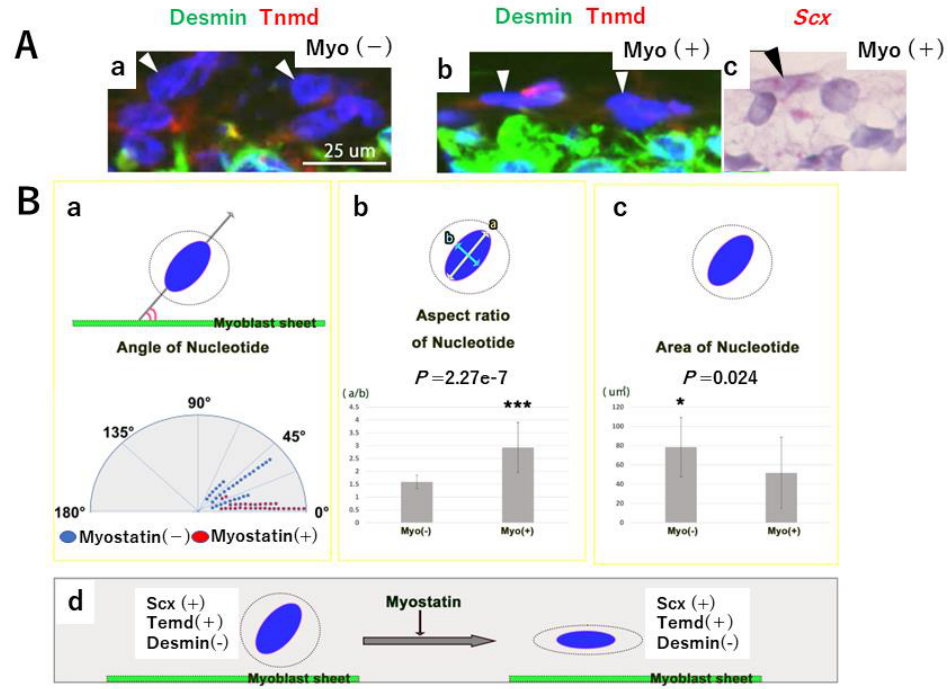
Figure 6. Boundary between C2C12 and gel in C2C12-Gel 3T3 after 1 week of culture. ( Panel A ) Morphology of S cells (white arrows) at the boundary between C2C12 and the gel in C2C12-Gel 3T3 (Panel a : Myo( − ), Panels b , c : Myo(+)). S cells in Myo(+) expressed Scx (Panel c). ( Panel B ) The angle between the cell sheet is significantly smaller in Myo(+) than in Myo( − ) cultures (Myo( − ): 28.53 ± 17.22 ◦ , Myo(+): 12.13 ± 5.13 ◦ ) (Panel a ). The long axis of the cell nucleus is significantly smaller in Myo( − ) than in Myo(+) cultures (Myo(-): 1.52 ± 0.23, Myo(+): 2.98 ± 1.02) (Panel b ). The cross-sectional area of the nuclei of S cells in Myo(+) and Myo( − ) cultures is significantly smaller in Myo(+) than in Myo( − ) cultures (Panel c ) (Myo( − ): 79.87 ± 30.5 µ m 2 , Myo(+): 53.23 ± 32.23 µ m 2 ). Ten S cell nuclei are randomly selected from each of the three Myo(−) and Myo(+) samples (10 nuclei × 3 samples = 30 nuclei). S cell nuclear morphology in Myo(+) and Myo(−) cultures (Panel d ). * p < 0.05 and *** p < 0.001.